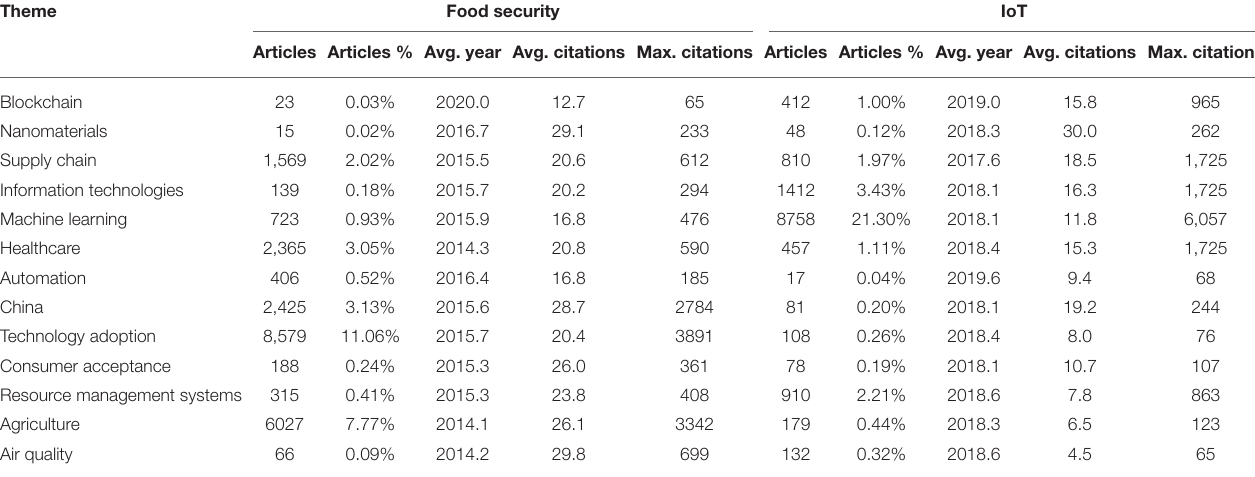
TABLE 6 | Transversal themes across food security and IoT.